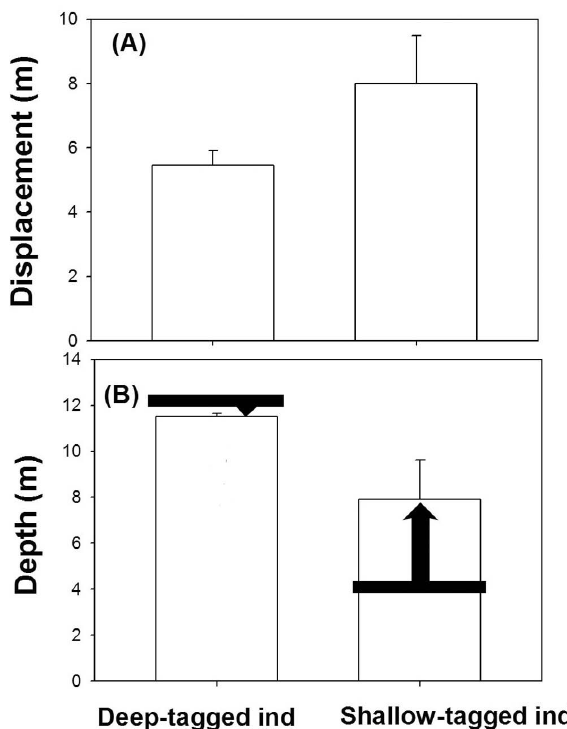
F ig . 6. – Movement of tagged M. glacialis. (a) Linear displacement, (m) and (b) depth of shallow- and deep-tagged individuals after 2 days. The arrows indicate the net movement of individuals across the vertical axis from the depth where tagged individuals were re- leased (black horizontal lines). Error bars are + SE of means (n=6 for shallow-tagged individuals and n=25 for deep-tagged individuals).